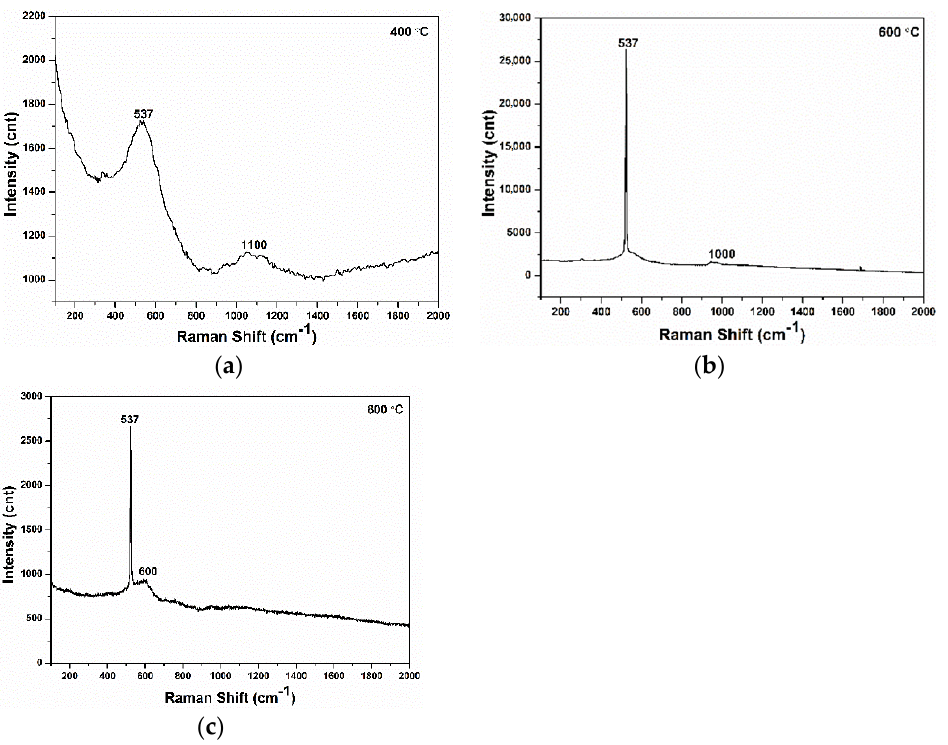
Figure 6. Raman spectra of mixed oxides NiO/ZnO/Al 2 O 3 were obtained with different process temperatures: ( a ) 400 °C; ( b ) 600 °C; ( c ) 800 °C.